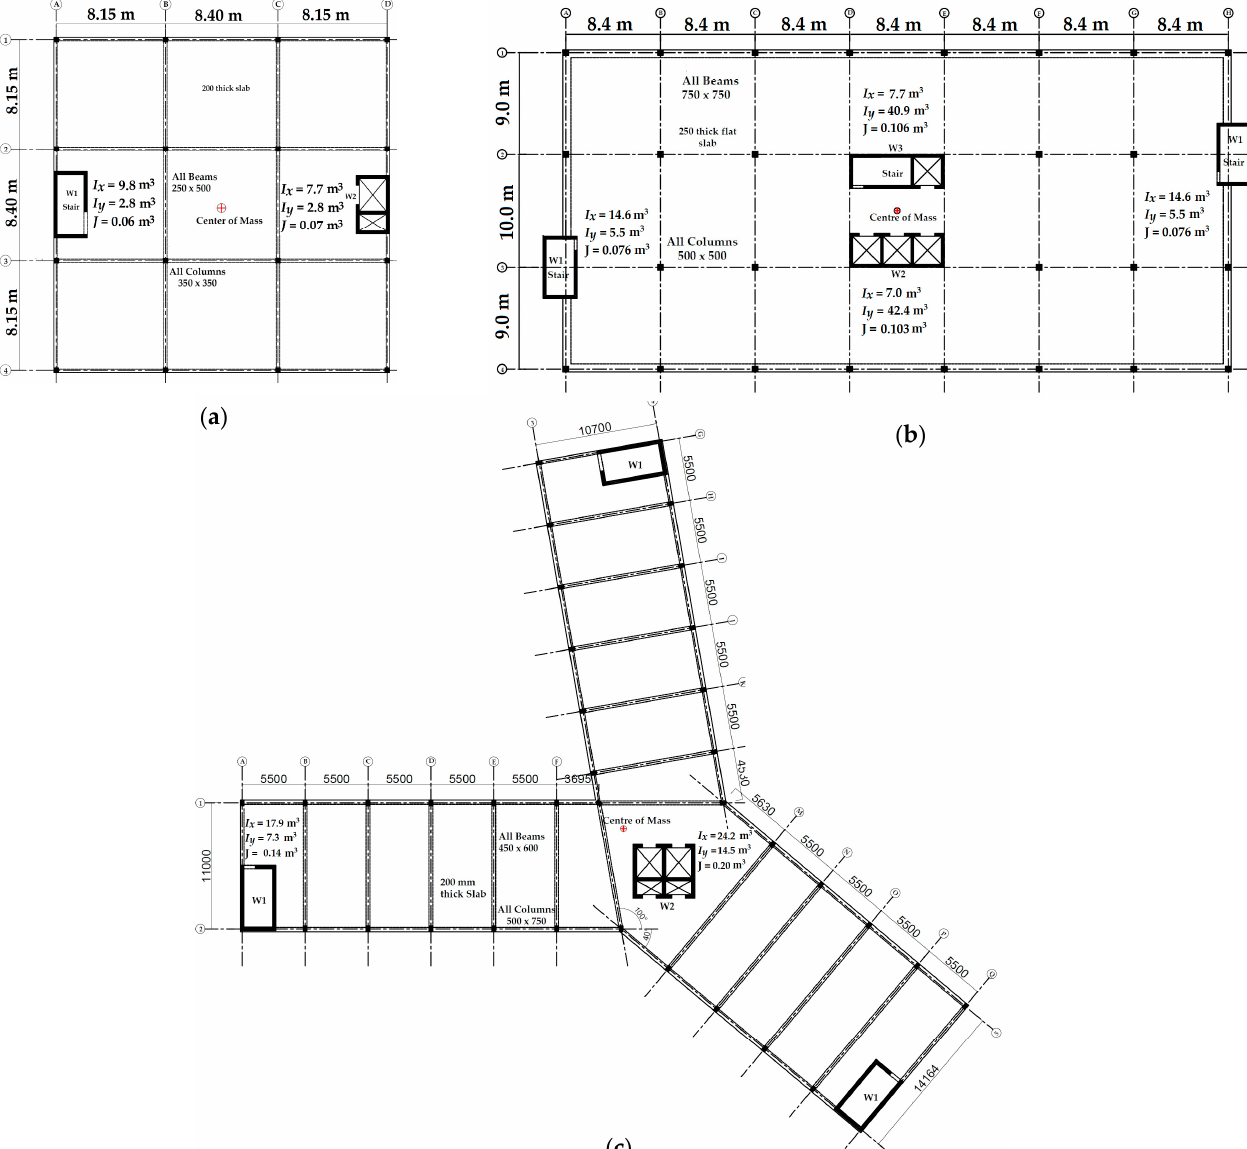
Figure 6. Structural details of the asymmetrical buildings: ( a ) Model ‘k’ [16], ( b ) Model ‘l’ [27], and ( c ) model ‘m’ [16].